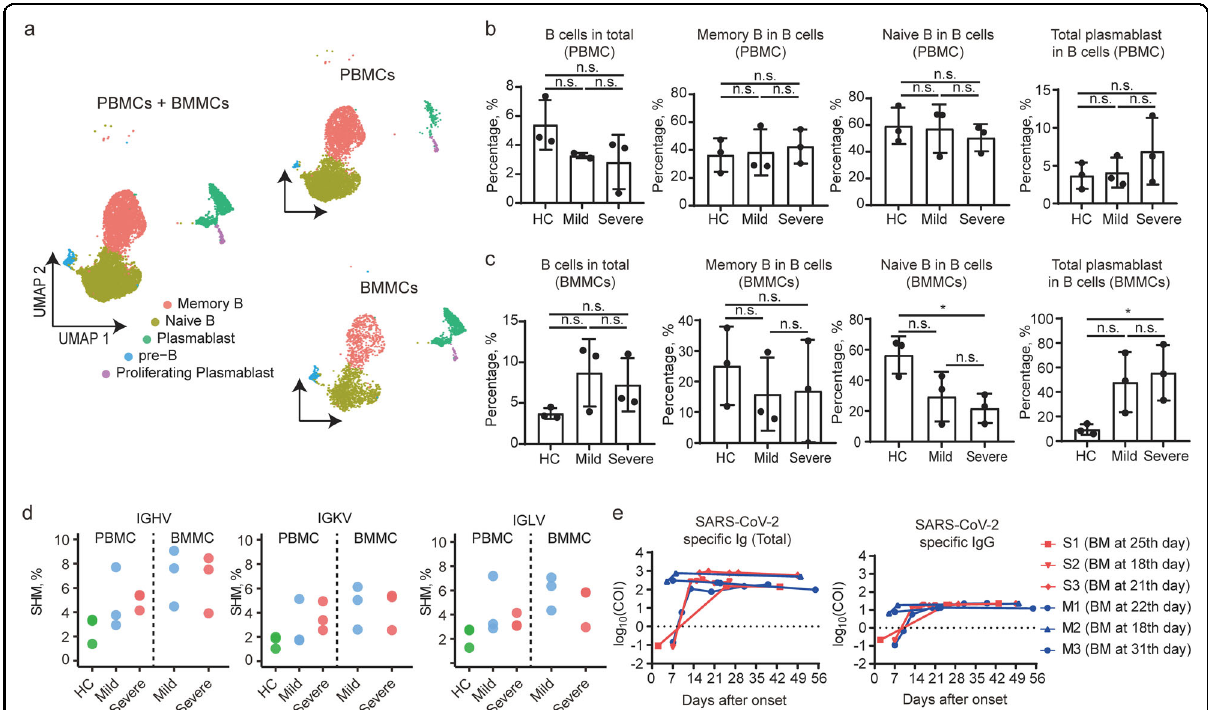
Fig. 5 Analysis of B cells from BMMCs and paired PBMCs and production of SARS-CoV-2-speci fi c antibody in COVID-19 patients. a UMAP plot of B cells from BMMCs and PBMCs. b , c Proportion of B cells among total cells and three types of B cells among total B cells, with results from PBMC samples ( b ) and BMMC samples ( c ). d Somatic hypermutation rate of IGHV, IGKV, and IGLV from three groups and two origins. e Total SARS- CoV-2-speci fi c antibody titers and SARS-CoV-2-speci fi c IgG titers of six patients at different time points after symptom onset. The BM puncture was done between the 18th and 31st day after symptom